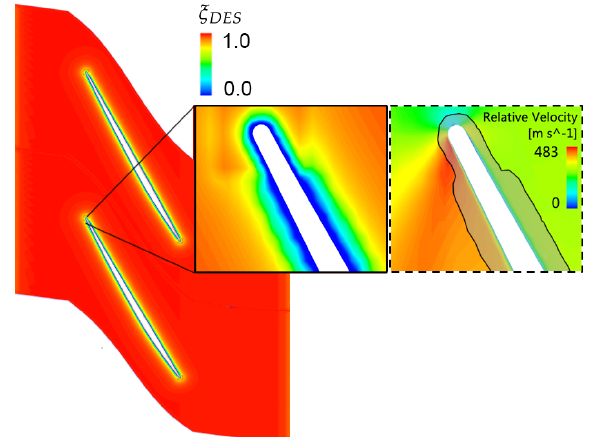
Figure 9. LES and RANS regions in DES results at 90%